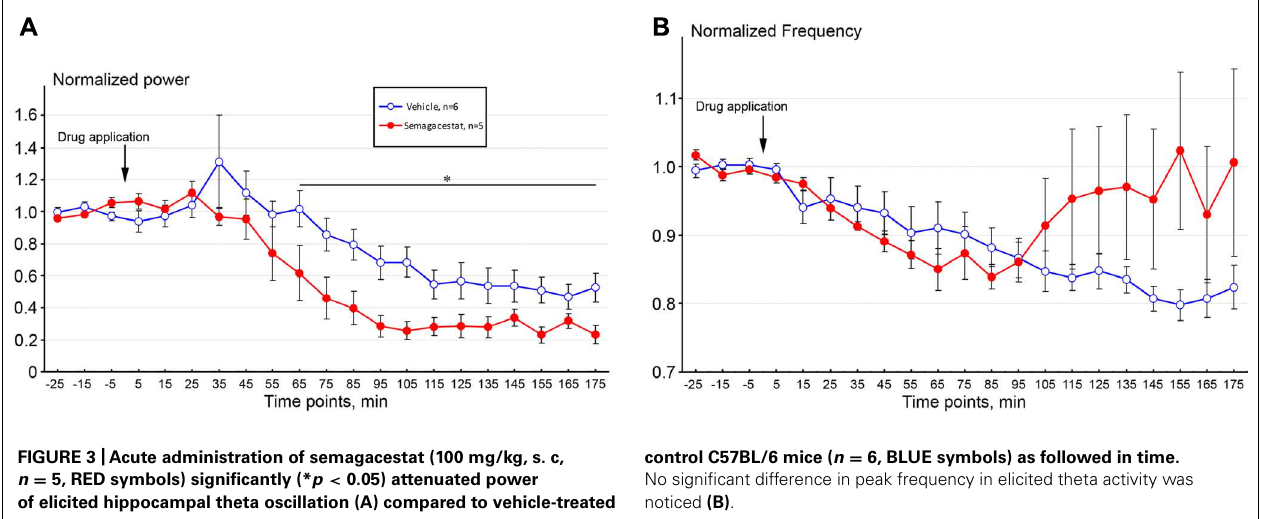
control C57BL/6 mice ( n = 6, BLUE symbols) as followed in time. No significant difference in peak frequency in elicited theta activity was noticed (B) .